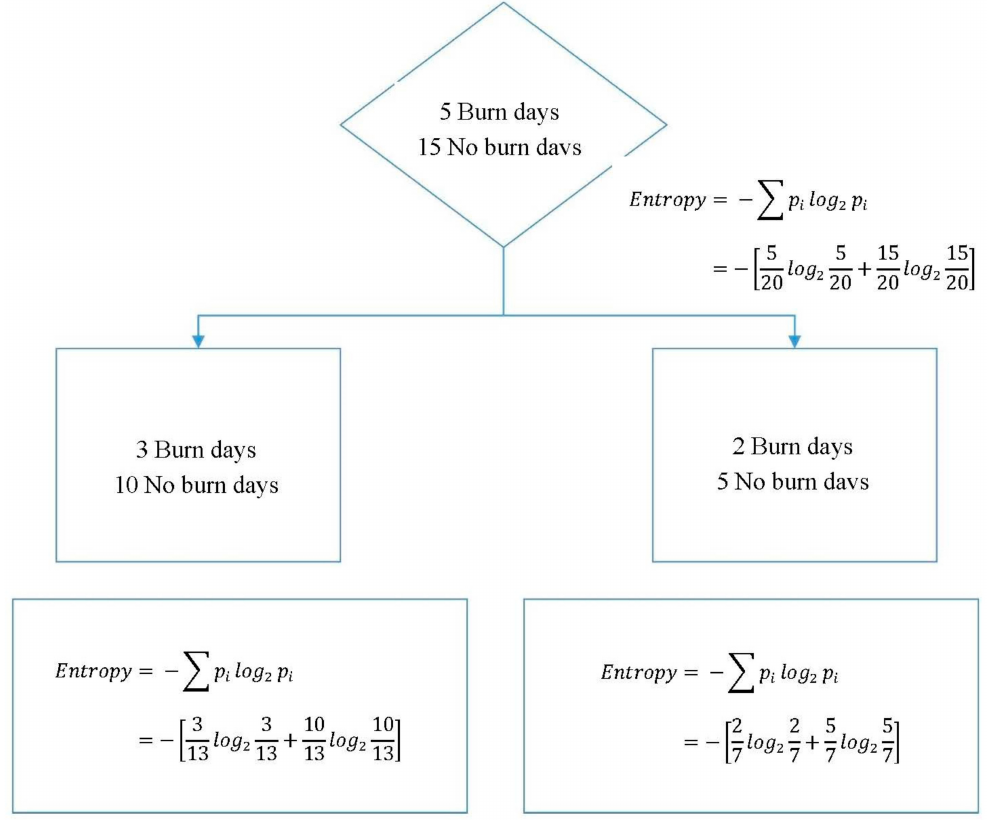
Figure A3. Information gain